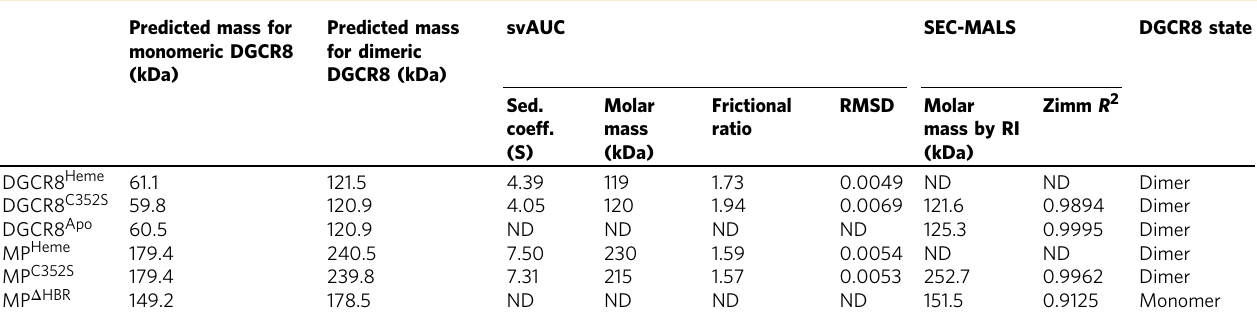
Table 1 Results of SV-AUC and SEC-MALS experiments Predicted mass for monomeric